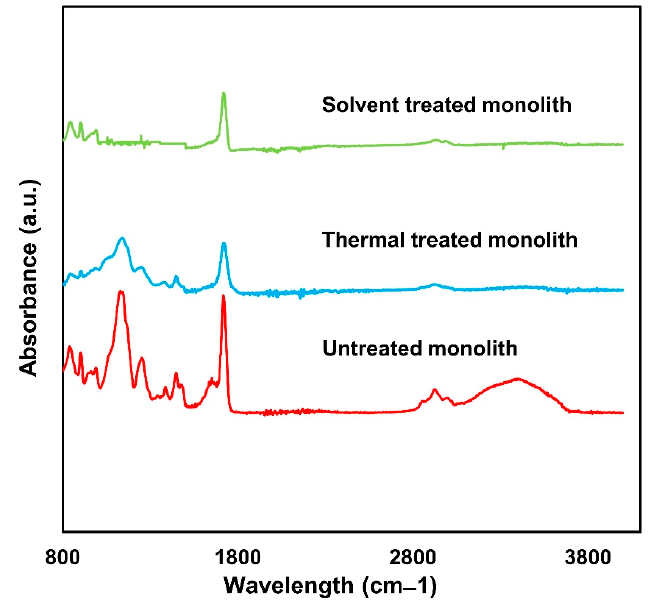
Figure 6. FTIR spectra of untreated monolith, thermal-treated monolith and solvent-treated monolith.